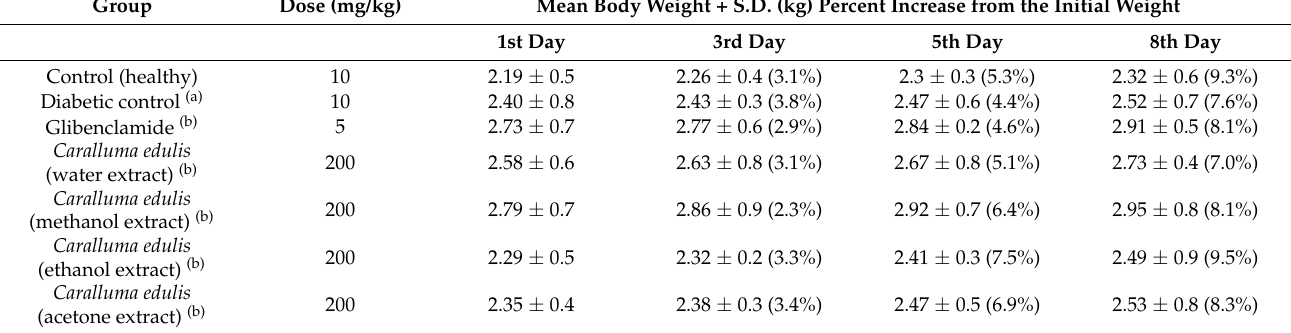
Table 11. Subacute effect of Caralluma edulis extracts on body weights in alloxan-induced diabetic